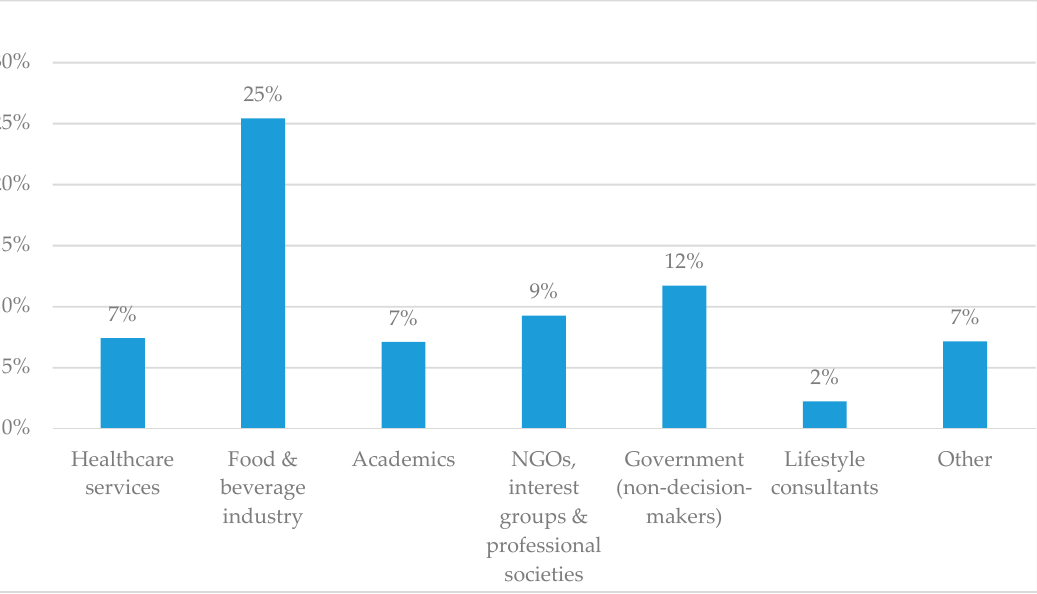
Figure 7. Relative capacity of professional categories to access decision-makers, represented as direct